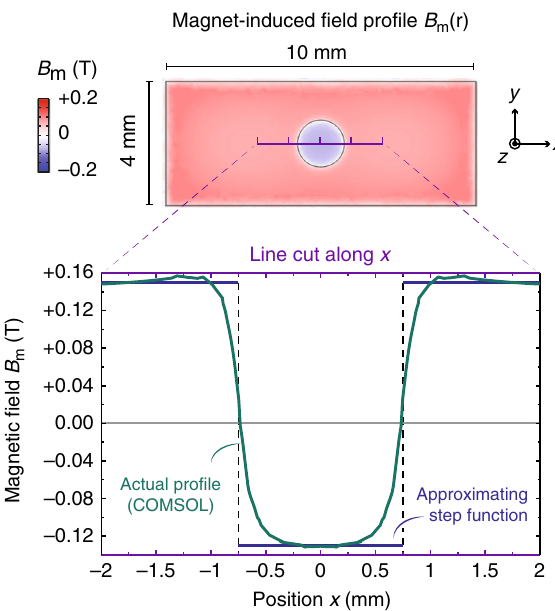
Fig. 6 Calculated magnetic fi eld pro fi le of the holed NdFeB magnet at low temperature. The simulation parameters are obtained from the Hall-probe measurement at room temperature and extrapolated into low